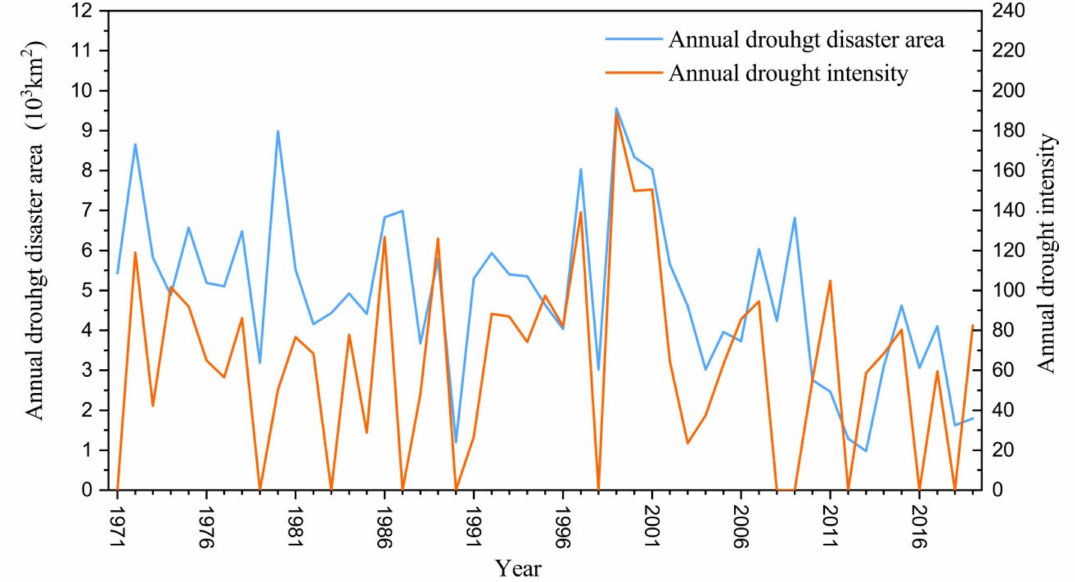
Figure 9. Variations of average annual drought process intensity and annual drought disaster area in North China from 1971 to